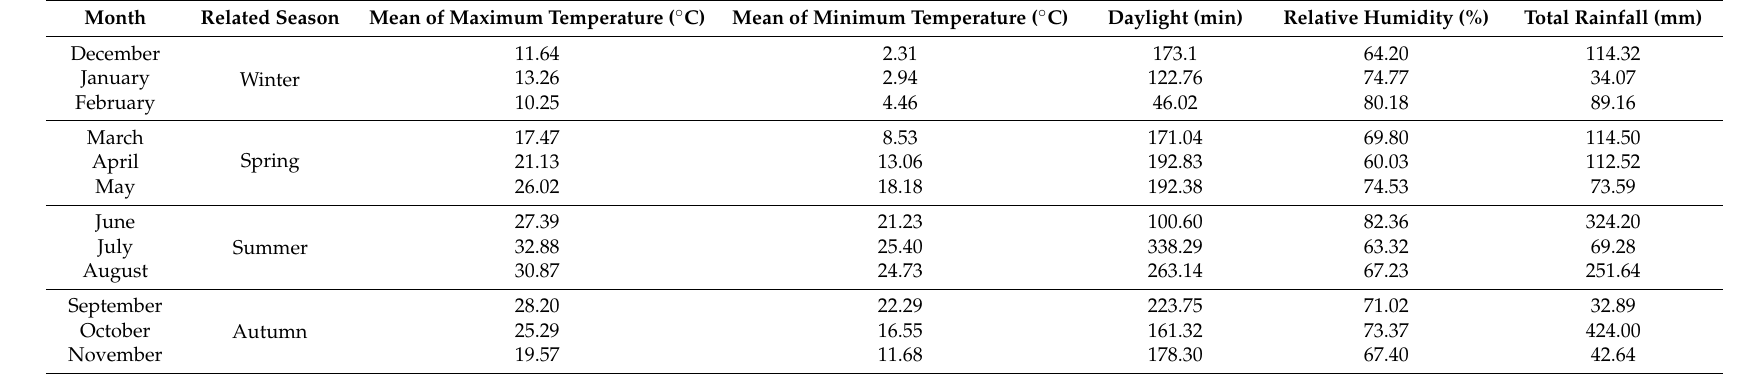
Table 2. Growth conditions of T. wallichiana var. mairei during